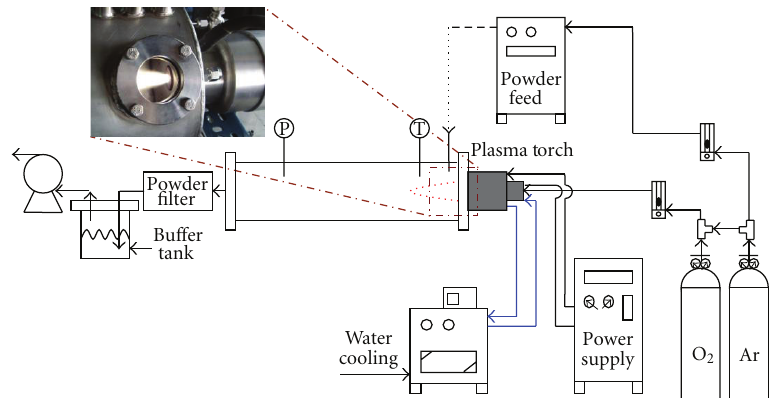
Figure 1: Schematic diagram of non-transferred DC plasma torch system for synthesis Al-doped TiO 2